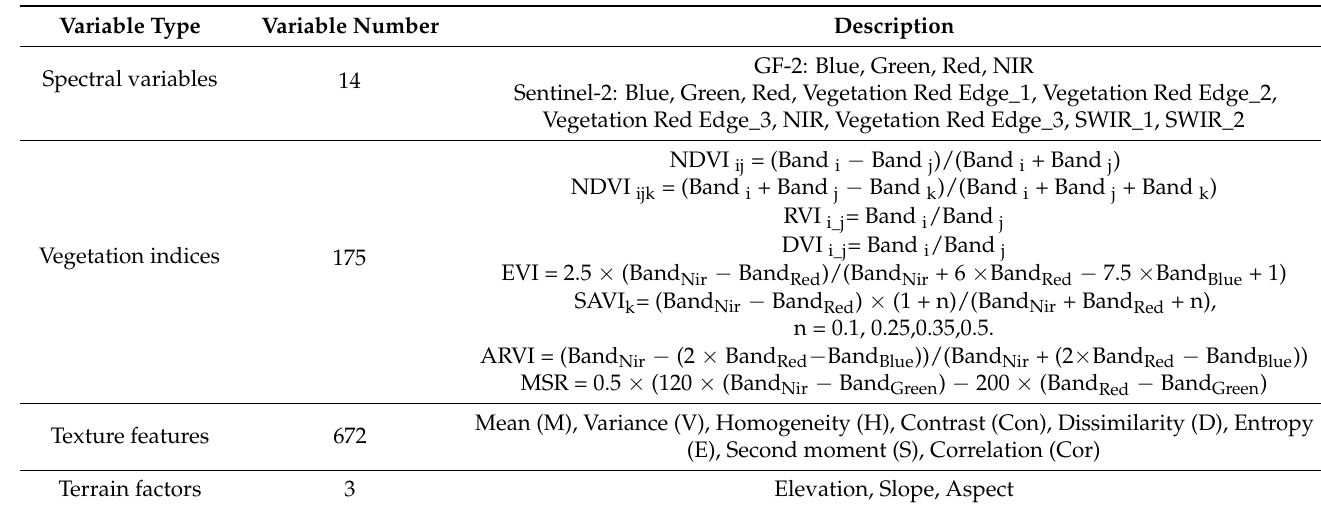
Table 4. Feature variables used in this study. Window sizes for extracting texture factors were 3 × 3, 5 × 5, 7 × 7, 9 × 9, 11 × 11, and 13 ×